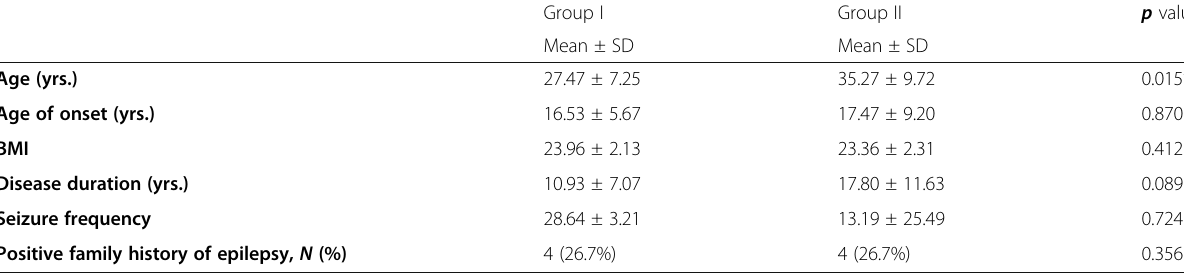
Table 1 clinical and demographic results of the patients in groups I and